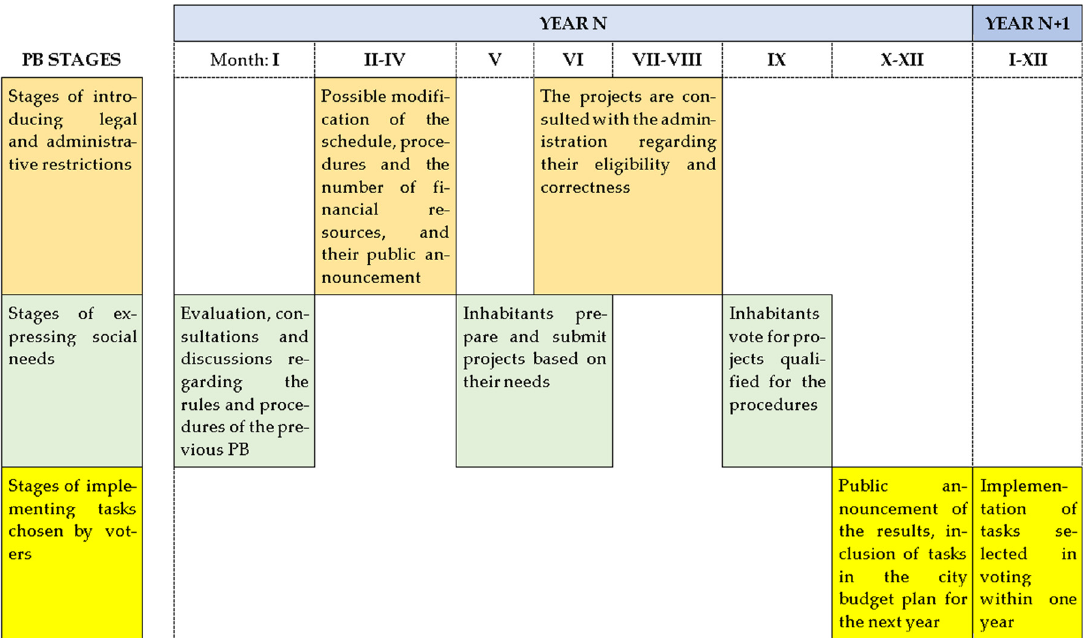
Figure 1. A simplified block diagram of PB procedures in Cz˛estochowa. The breakdown into procedural stages by month is schematic as the dates of the individual stages of the PB change from year to year. Source: Prepared by